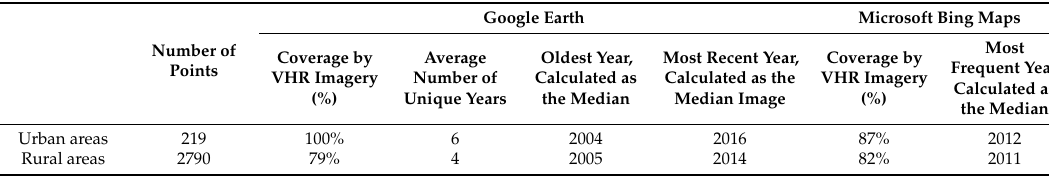
Table 6. Availability of VHR imagery (<5 m) in urban and rural